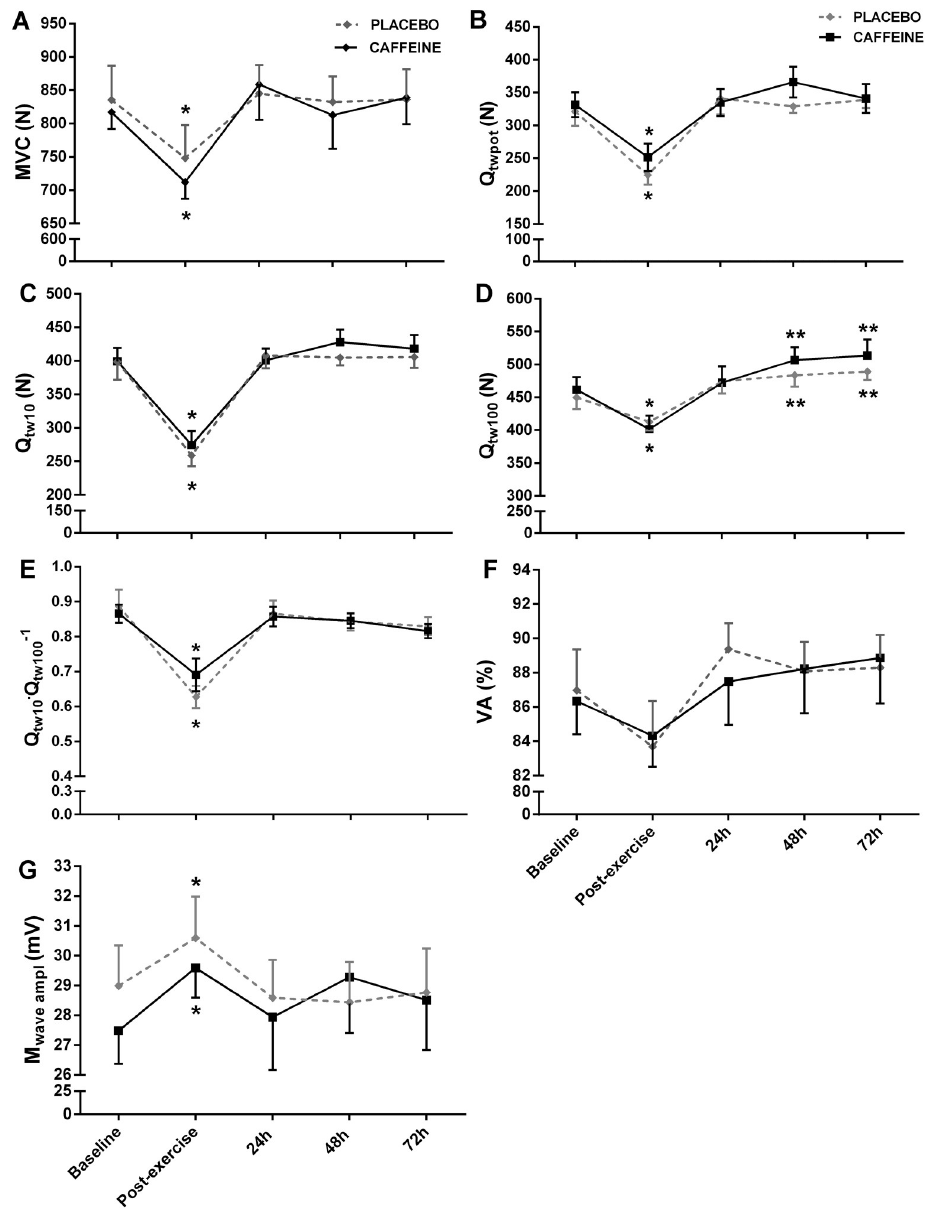
Fig 3. Neuromuscular function assessed before and after a half-squat exercise, and at 24, 48 and 72 h after placebo or caffeine ingestion. Values are expressed as mean ± SEM. A: MVC, maximal voluntary contraction; B: VA, voluntary activation; C: M wave ampl , maximal M-wave amplitude; D: Q twpot single stimulation (potentiated twitch); E: Q tw10 paired stimulations of 10 Hz; F: Q tw100 paired stimulations of 100Hz. G: Q tw10 � Q tw100 − 1 ratio. � Significantly lower than pre, 24, 48 and 72 h post half-squat exercise under both conditions; �� Significantly higher than pre- and post half- squat exercise under both